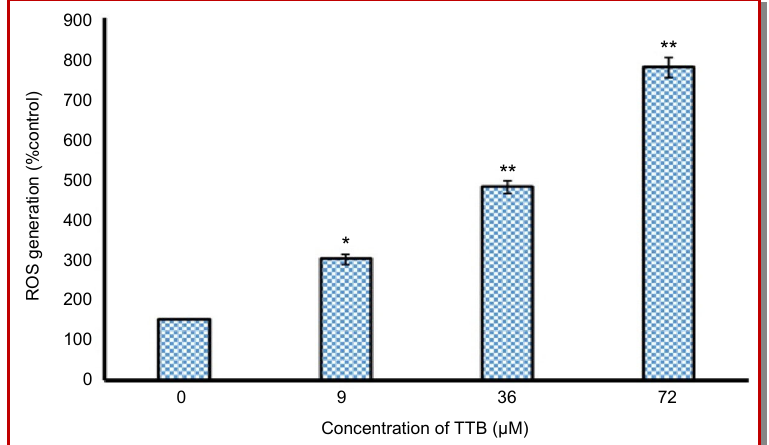
Figure 7: TTB-induced ROS generation in ME-180 cells. ME-180 cells were treated with TTB (0, 9, 36 and 72 mM) for 3 hours, and the ROS generation was evaluated using CM-DCFH2-DA staining by flow cytometry. **p<0.01; *p<0.05 vs. control